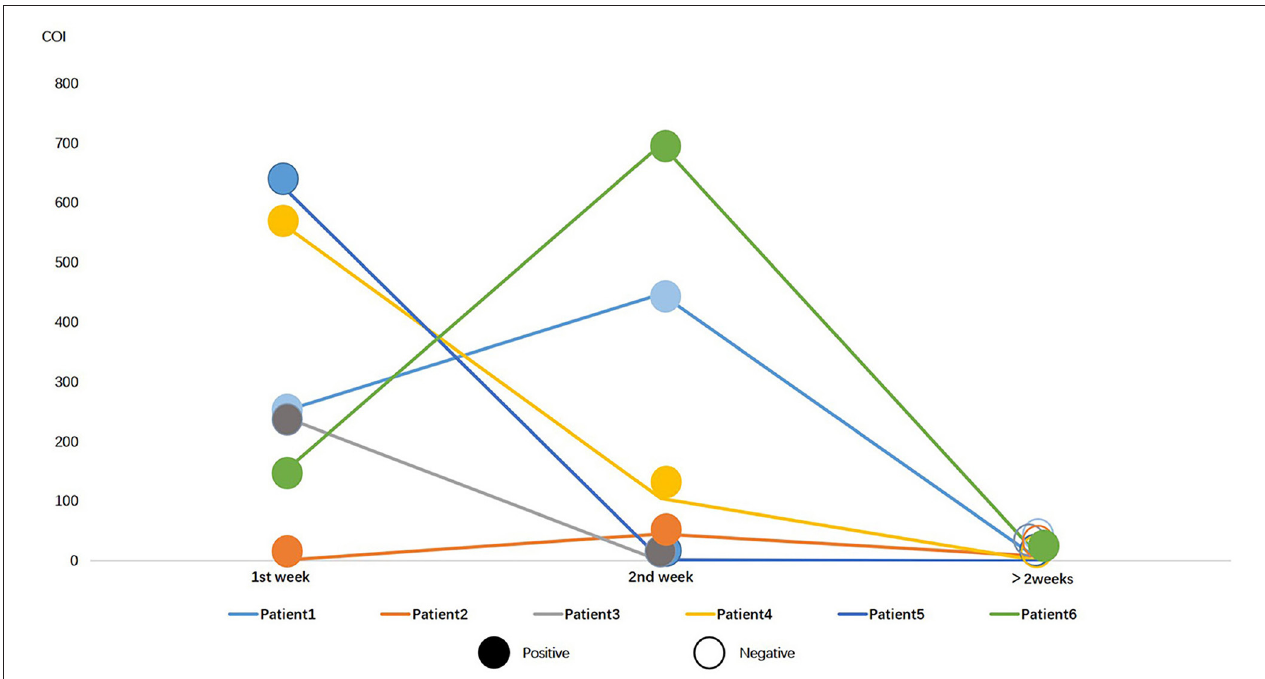
FIGURE 3 | Serial data of N protein antigen and RT-PCR for 6 COVID-19 patients in different periods. Colorful lines represent patients, solid circles represent positive RT-PCR result, and hollow circles represent negative